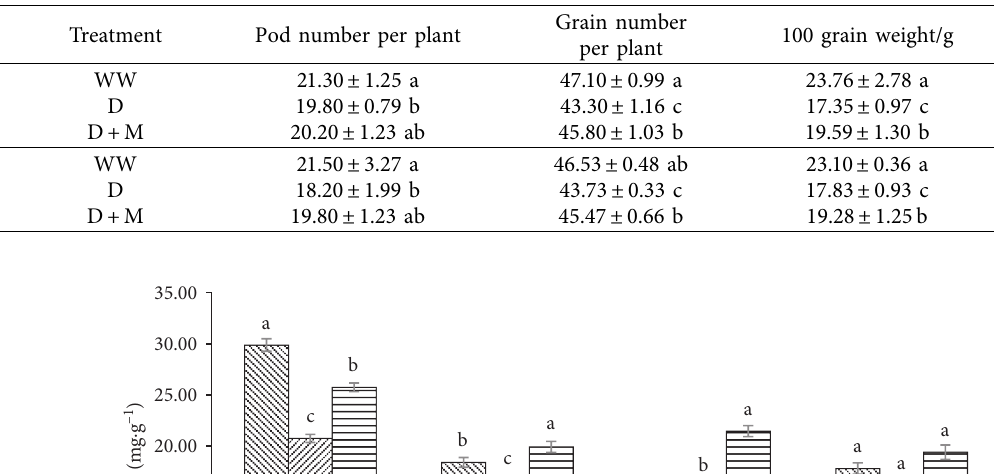
Table 2: Effects of melatonin treatment on yield components of soybean under drought stress.